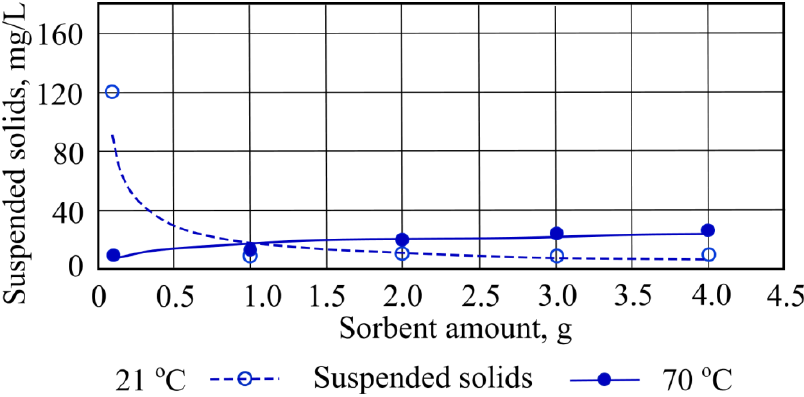
Figure 8. Suspended solids concentration when different quantities of hydrophobic peat sorbent are added to the wastewater.